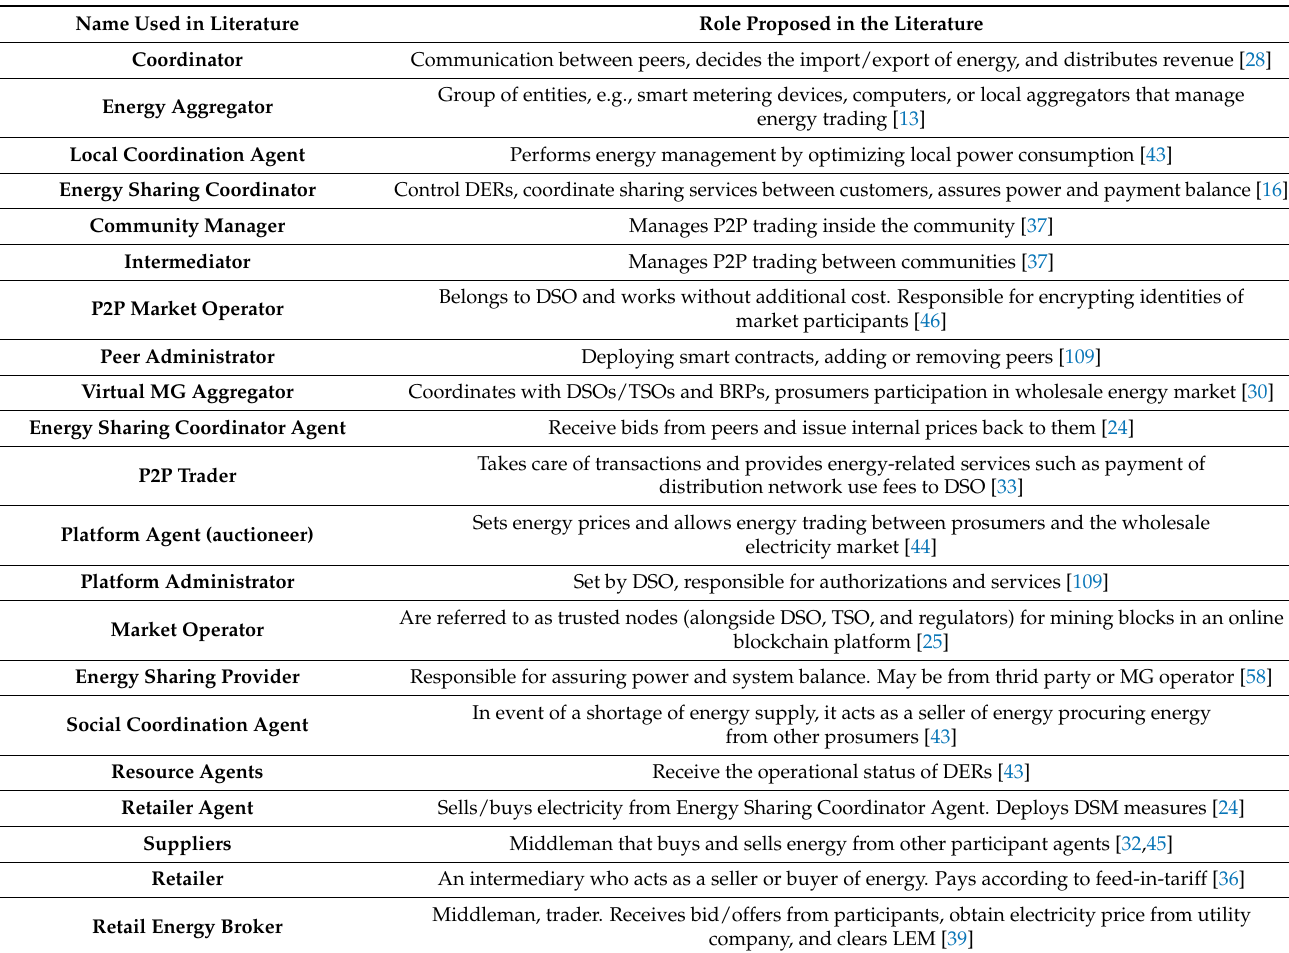
Table 8. Definition of actor roles in P2P-ET markets from the